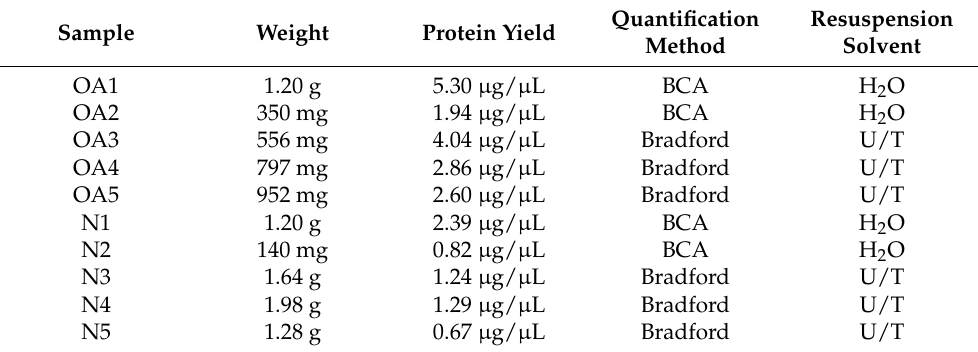
Table 2. Protein concentration yielded after histone extraction in relation to the weight of the sample. Quantification methods (bicinchoninic acid (BCA) and Bradford) and resuspension solvents (H 2 O and urea/thiourea (U/T) buffer) used in each case are indicated below. Quantification Sample Weight Protein Yield